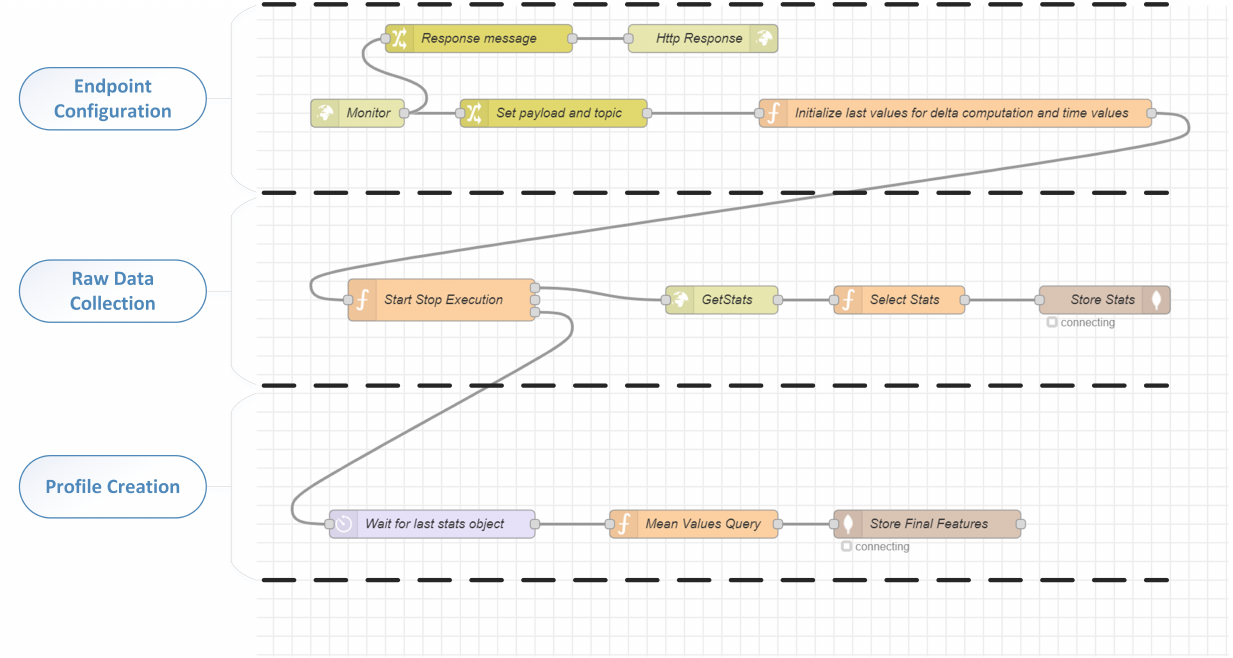
Figure 2. Profiling component internal processes